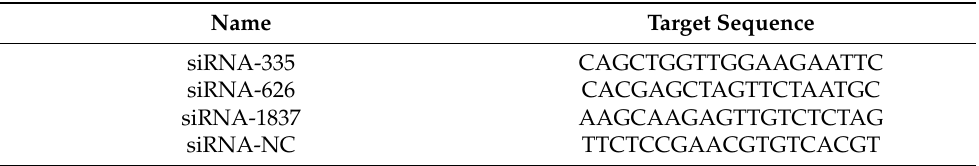
Table 1. siRNAs used in the RNA interference assay.